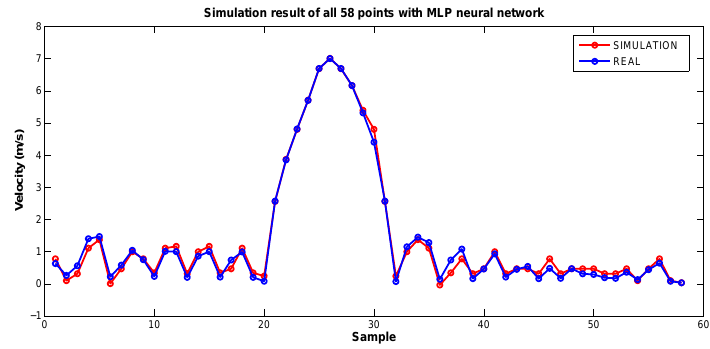
Figure 18. Simulation result of all 58 points with MLP neural network. Source: By Authors.